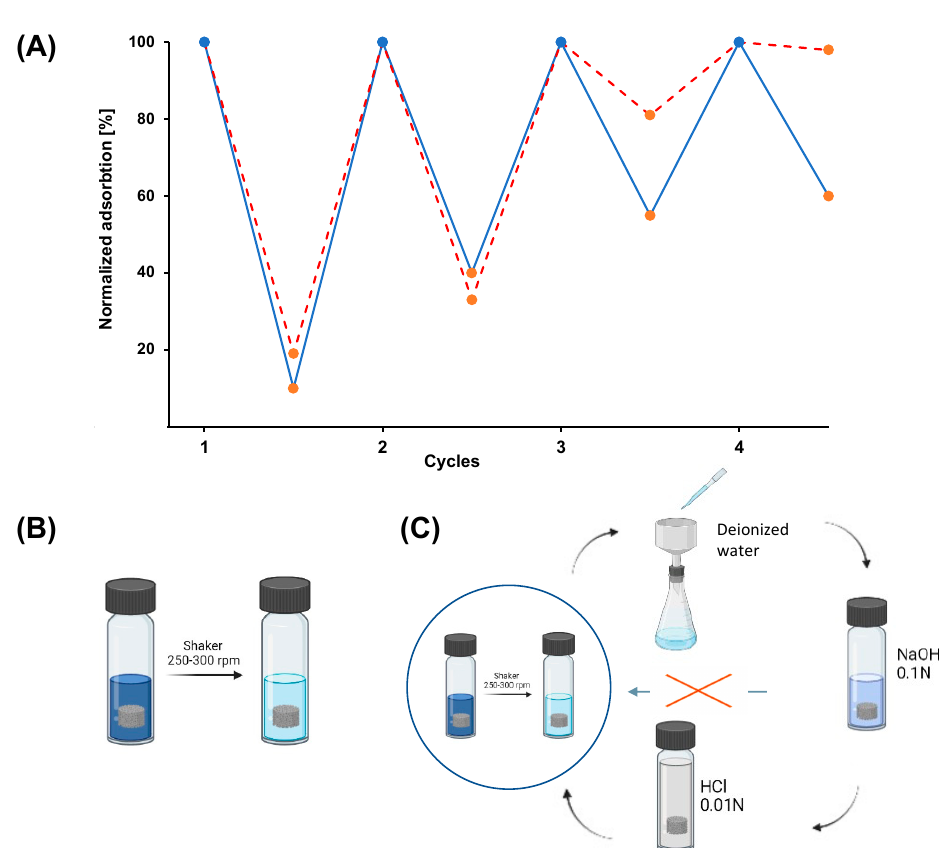
Figure 4. ( A ) Normalized adsorption (%) of the material versus the cycle of adsorption. The blue line represents the Indigo Carmine profile, and the dashed red line represents the Cibacron Brilliant Yellow profile. Blue dots represent the starting point for the adsorption test of each adsorption cycle, and orange dots represent the end of the adsorption cycle. ( B ) Schematization of the adsorption procedure. ( C ) Schematization of the regeneration procedure.